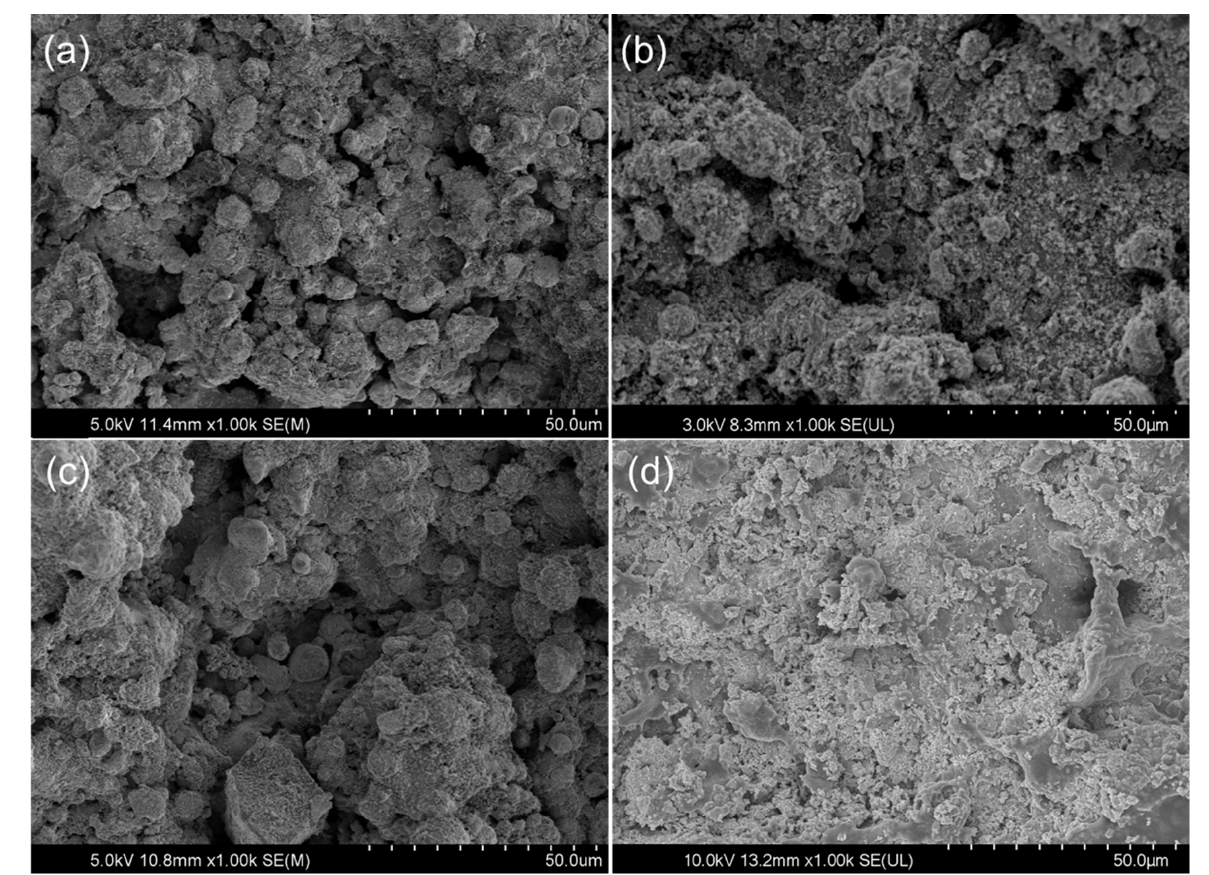
Figure 2. SEM images of ( a ) as-sprayed tantalum coating surface and surfaces tantalum coatings thermal treated at: ( b ) 200 °C, ( c ) 400 °C, and ( d ) 600 °C.